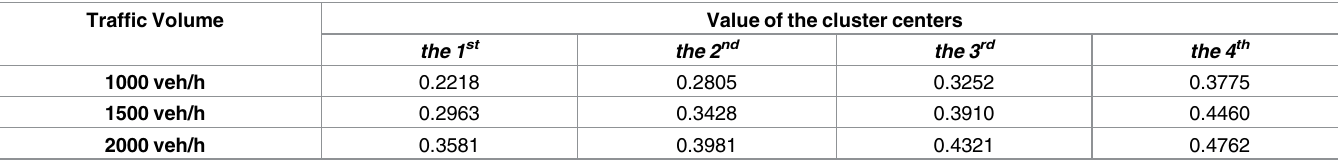
Table 4. Results of cluster